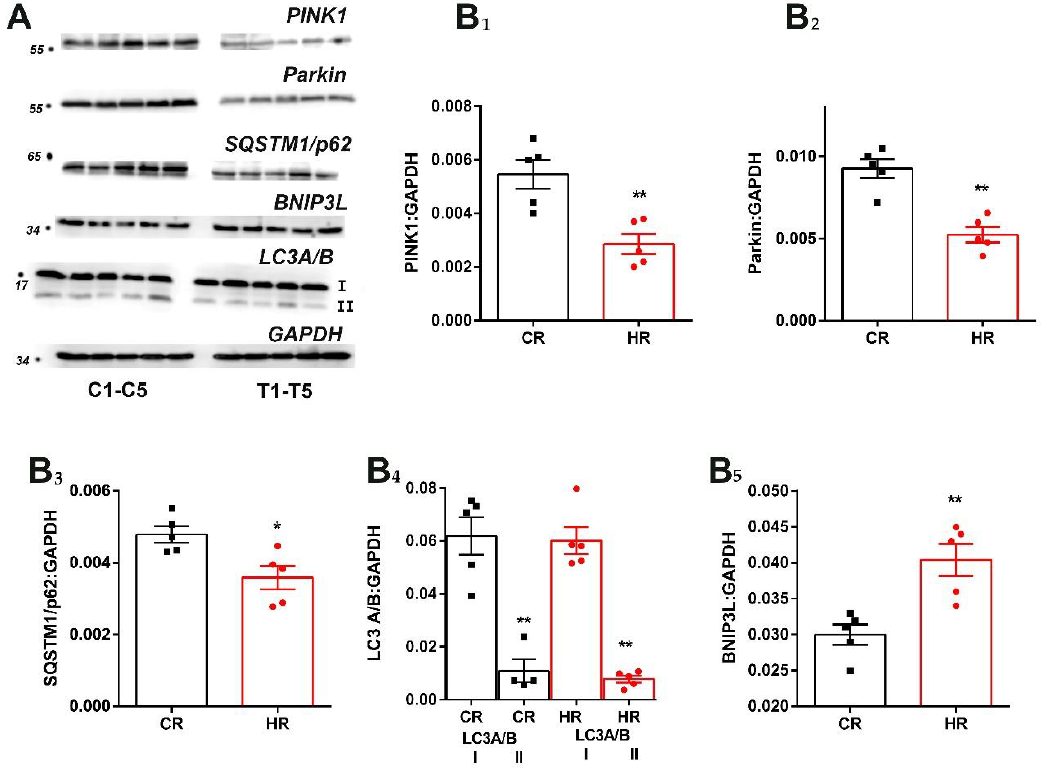
Figure 5. Immunoblotting analysis of mitophagy proteins in heart tissue of the control and hyper- thyroid rats: ( A ) representative Western blot of Parkin, PINK1, SQSTM1/p62, BNIP3L, LC3A/B-I-II, C 1 -C 5 -CR and T 1 -T 5 -HR; ( B ) relative levels of the appropriate proteins with respect to the loading control (GAPDH). CR, control; HR, hyperthyroidism. * p < 0.05 and ** p < 0.02, as compared with the control data (n = 5).